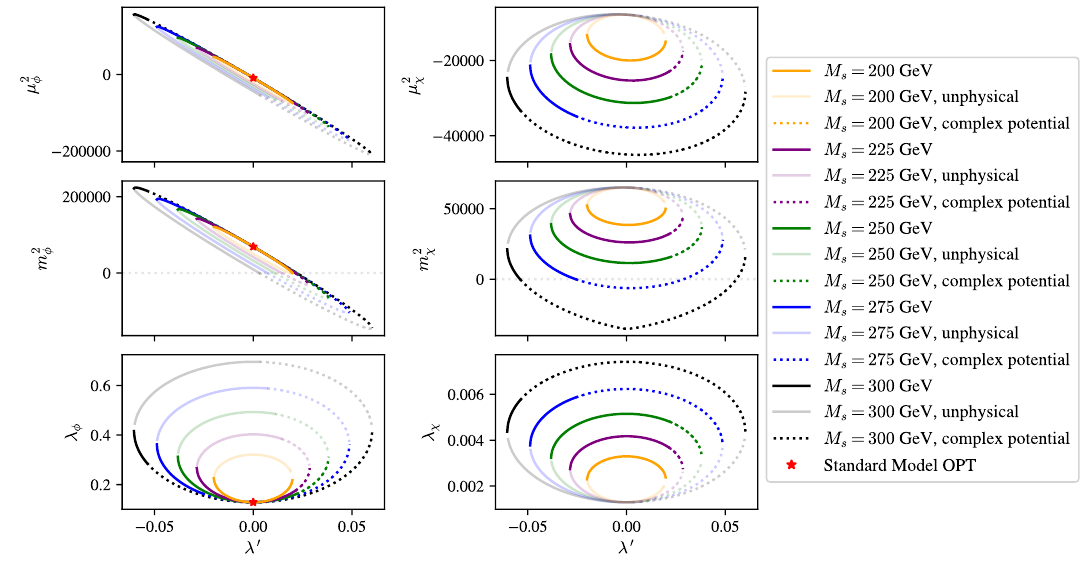
Figure 4 . Parametrization of the singlet extended SM for w 0 = 10 v 0 at various values of the scalar mass M s . The solid curves indicate physical solutions where the potential remains real for all values of the background fields. The light solid curves are the unphysical solutions, while the dotted lines indicate physical parameter values where the potential becomes complex in some region of v < v 0 and w < w 0